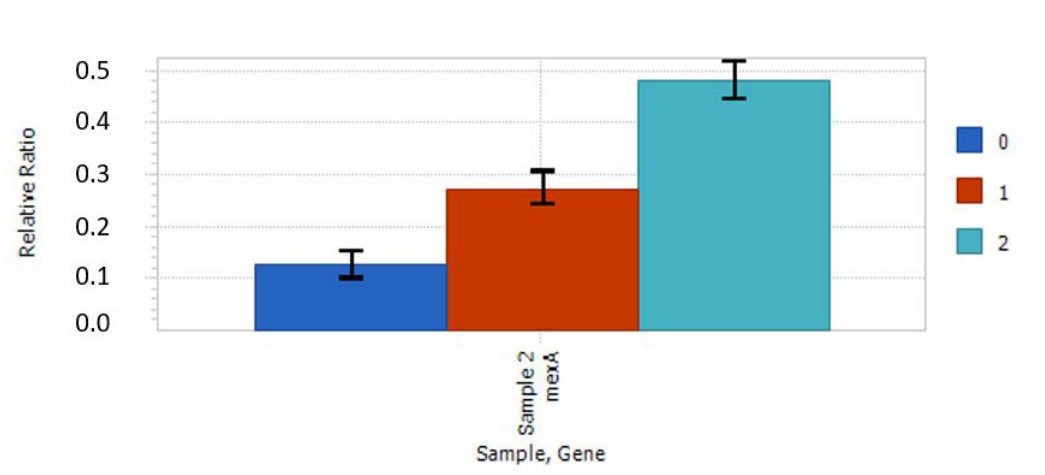
Figure 6. Expression of mexA gene (measured in RT-qPCR) in P. aeruginosa PAO1 in response to titanium dioxide / silica nanotubes in comparison to the control; 0—0.01 mg / mL, 1—0.05 mg / mL, 2—0.1 mg / mL.